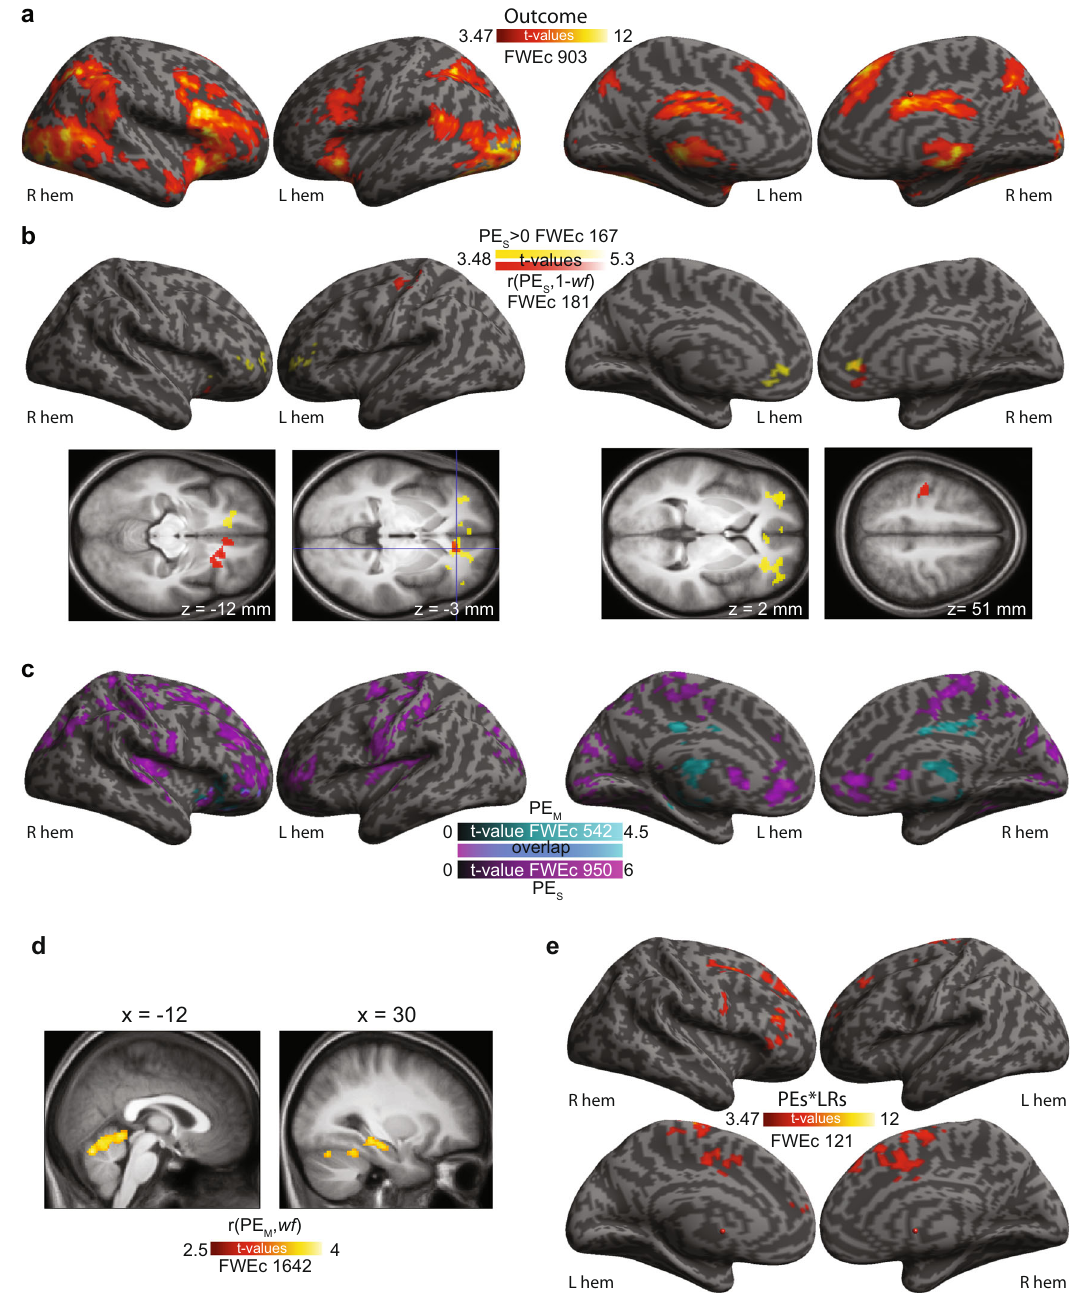
Fig. 7 | Key fMRI results. a Voxels where BOLD signals are increased during the outcome phase, independently of prediction errors, (Outcomes>0), p unc <0.001, k =FWEc=903voxels(SupplementaryTable8). b Red:regressionbetweenPE S and 1- wf ( p unc <0.001, k =FWE c =181voxels, Supplementary Table 10). This identi fi es voxelswithsignalsthatincreasemoreforshockoutcomesthatarelessintensethan expected(i.e.,positivePE S )inparticipantsthatplacemoreweightsonshocks(high